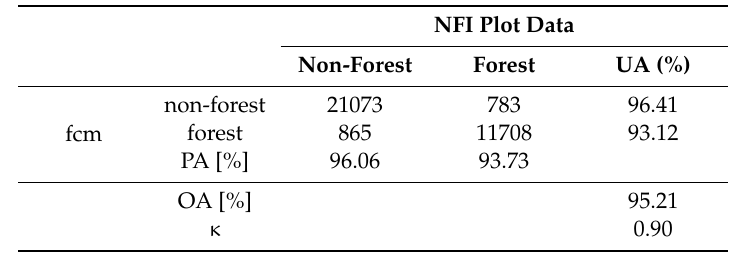
Table 2. Confusion matrix of NFI plot data and forest cover map (fcm). OA = overall accuracy, UA = user’s accuracy, PA = producer’s accuracy, κ = Kappa